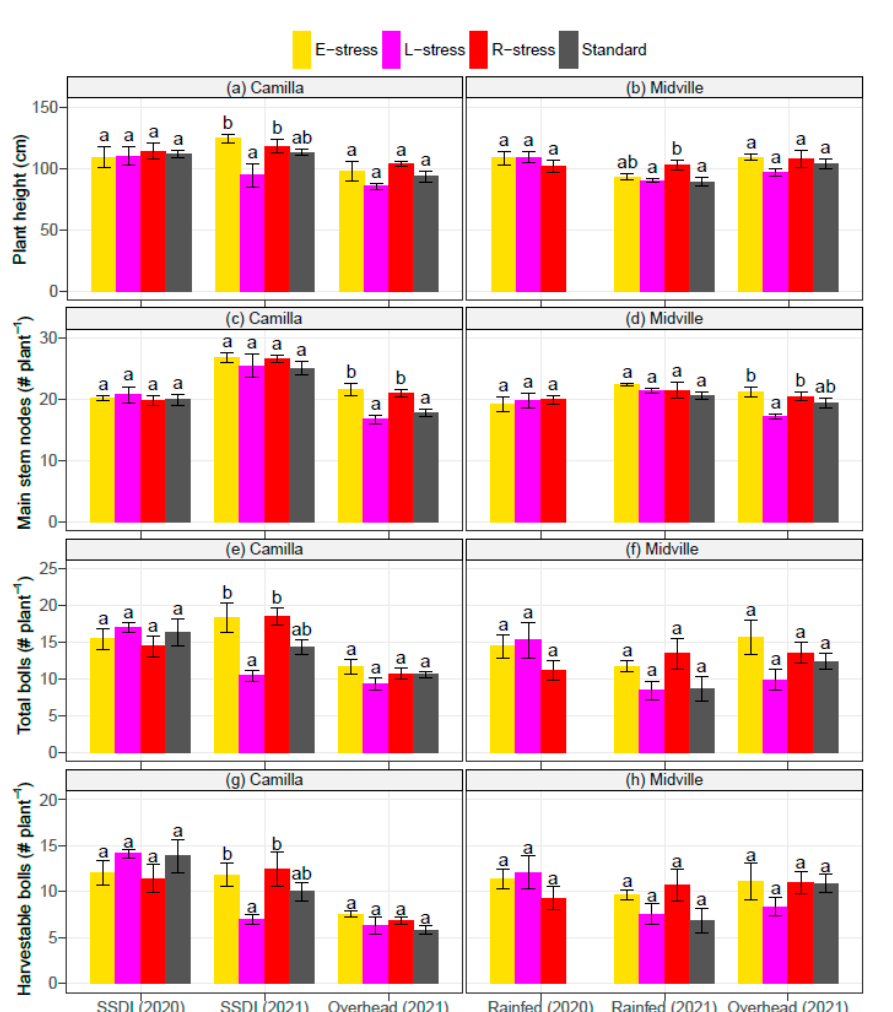
Figure 3. Nutrient stress effects on plant height ( a , b ), main stem nodes ( c , d ), and total ( e , f ) and harvestable ( g , h ) number of bolls in Camilla and Midville, GA under different production conditions. Within location and production conditions, means of nutrient stress treatments not sharing any letter are significantly different using the least squares means and adjusted Tukey multiple comparison procedure ( p < 0.05). Error bars indicate the standard error of the mean (n = 4). SSDI: Sub-surface drip irrigation.